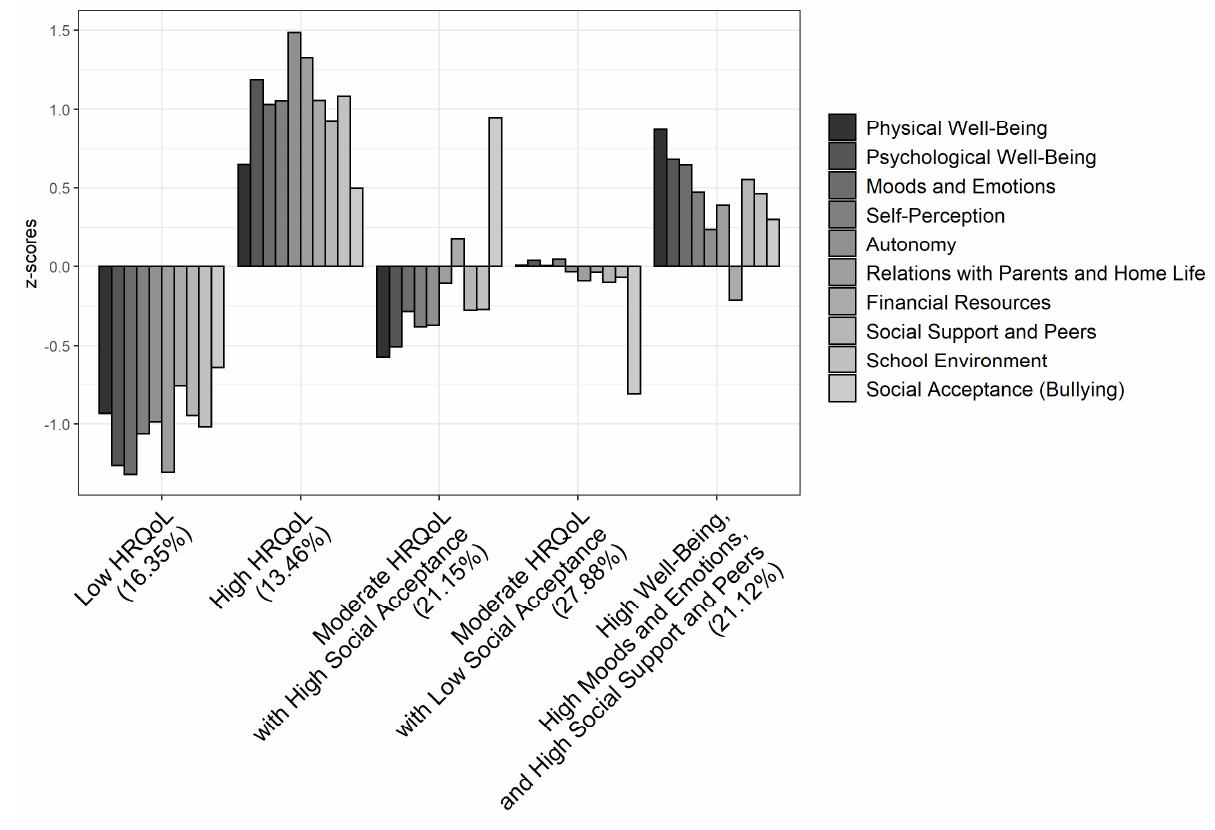
Figure 1. Cluster solution for HRQoL. n = 208. z-scores for Physical Well-Being, Psychological